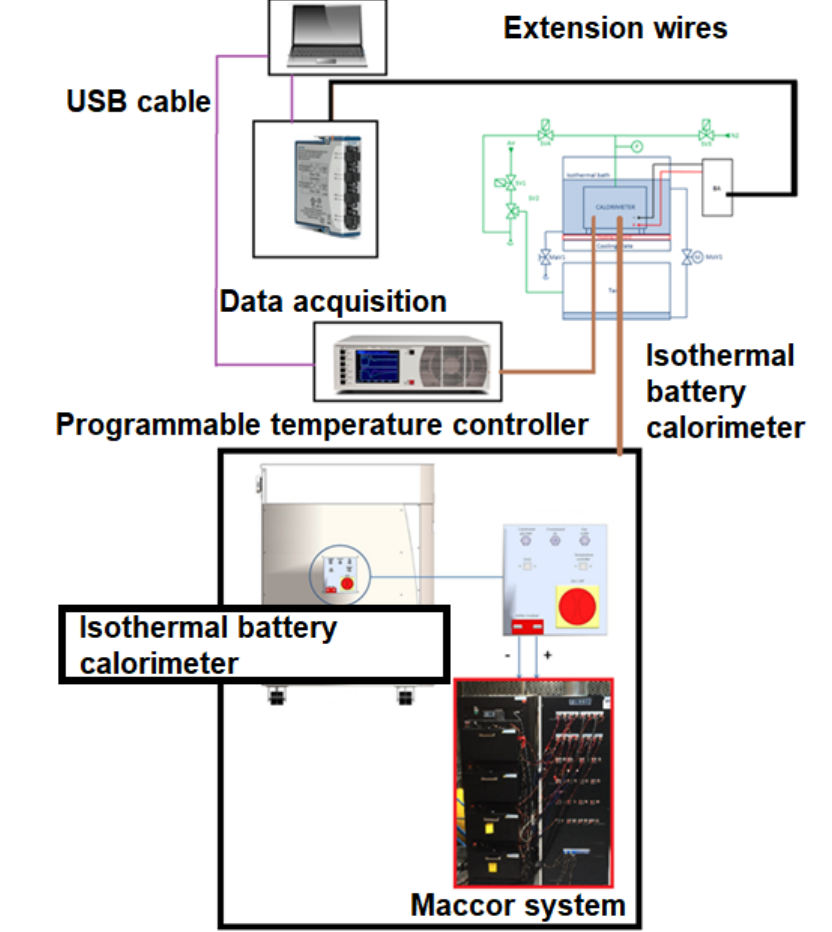
Figure 1. Experimental